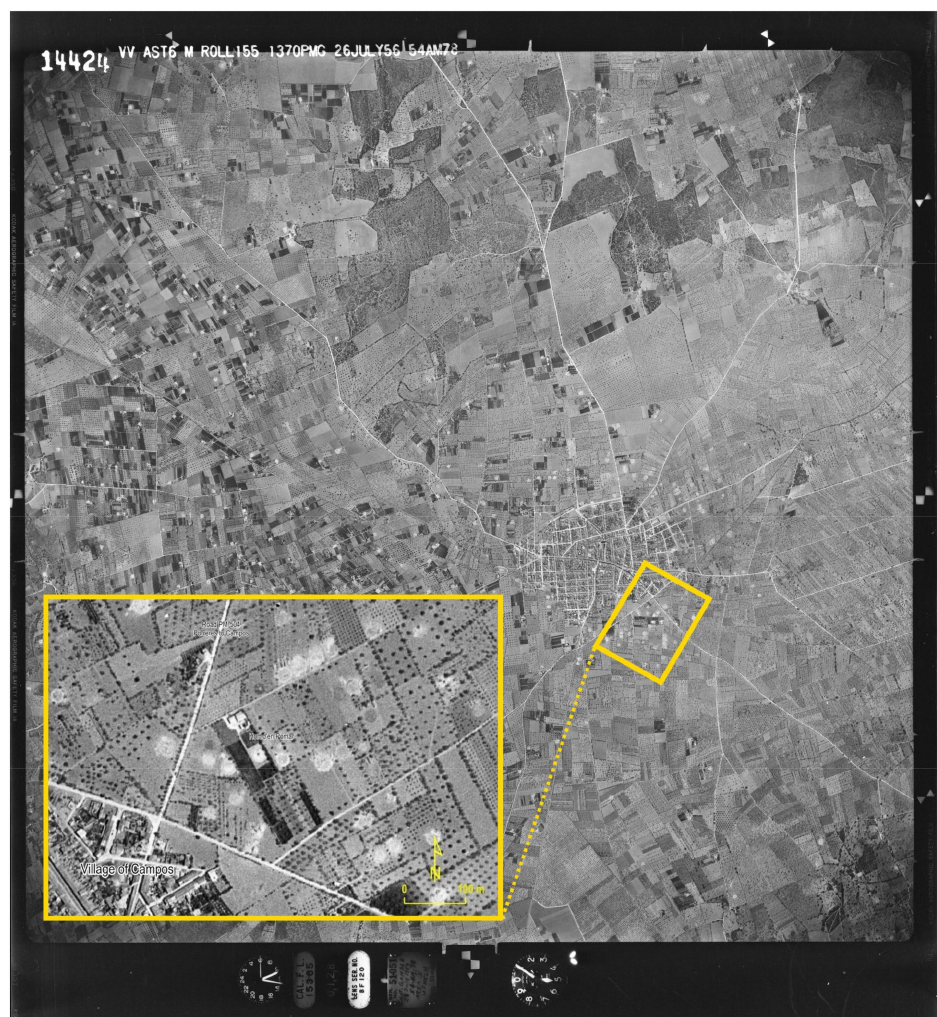
Figure 4. Photogram 14,424 of the flight on 26 July 1956. The village of Campos, in the south of Mallorca, is shown in the central-eastern part of the photograph, facing south-west. Campos is seen to be surrounded by an agricultural matrix. In the box, small, white circles are identified, indicating the location of threshing floors, which are very numerous on the peripheral fringe of this